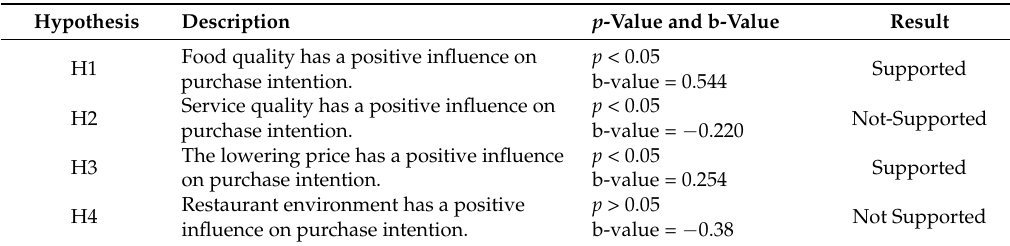
Table 5. Summary of